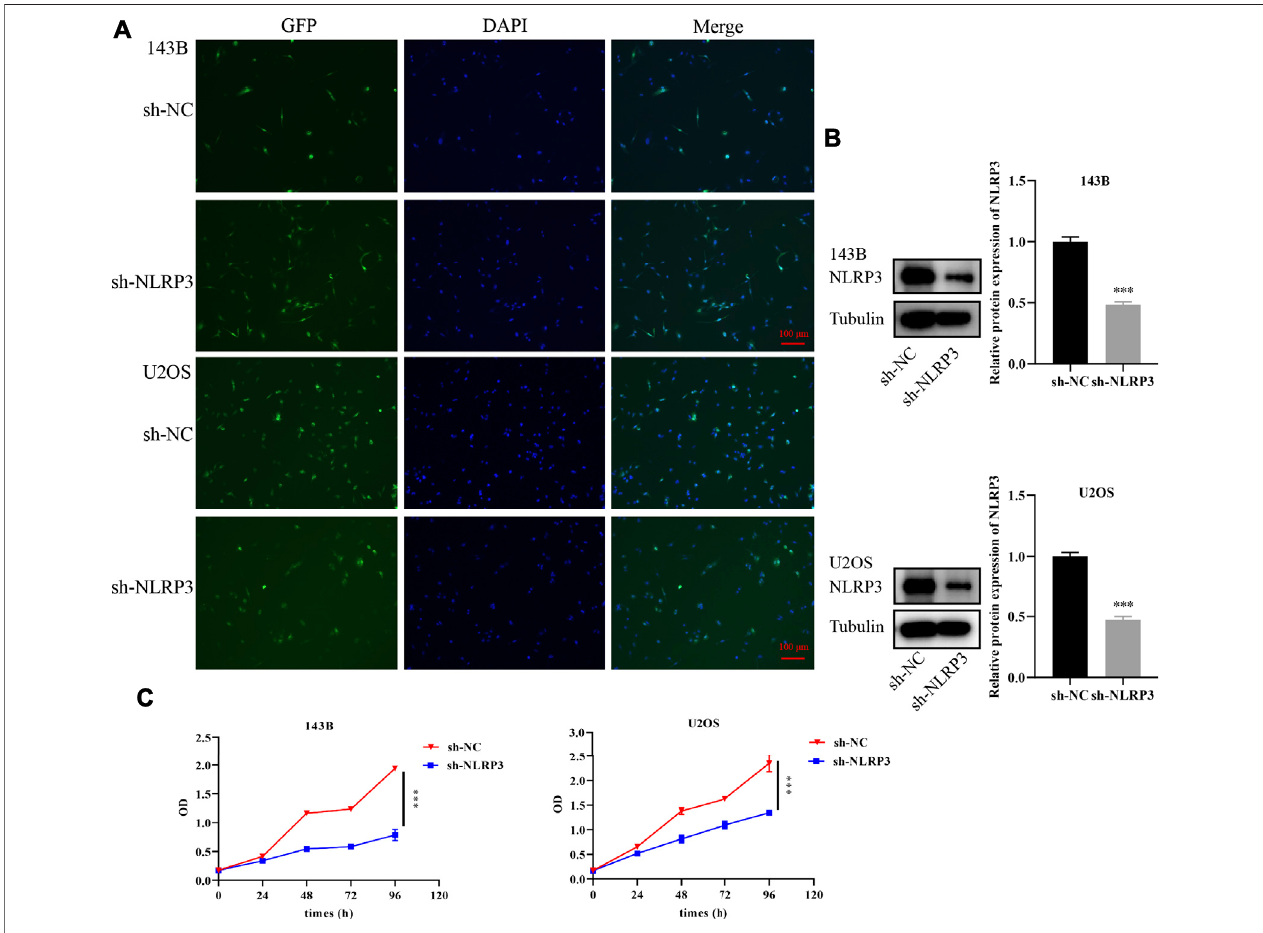
FIGURE 3 | Knockdown of NLRP3 gene and cell viability changes in 143B and U2OS cells (A) Infection ef fi ciency of lentivirus in 143B and U2OS cells (B) Interference effect of 143B and U2OS cells veri fi ed by western blot analysis (C) Th changes of cell viability in 143B and U2OS cells after NLRP3 knockdown detected by CCK-8. The experiments were conducted in triplicate.